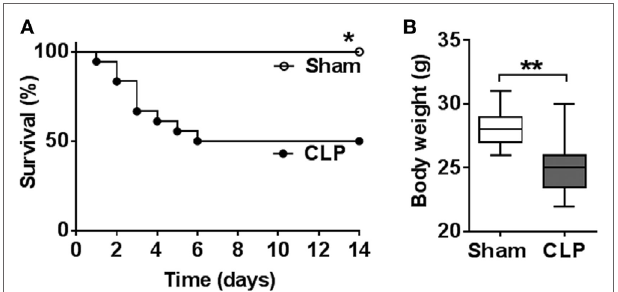
FigUre 1 | Sepsis mortality following cecal ligation and puncture (CLP) surgery and weight loss in sepsis survivors. (a) CLP causes mortality rate of 50% by day 6 and no later mortality until day 14 following surgery. * P = 0.0142, Log-rank test, n = 9 per group. (B) Fourteen days following CLP, mice exhibit lower body weight as compared to sham-operated controls. *** P = 0.0052, Student’s t -test, n = 9 per